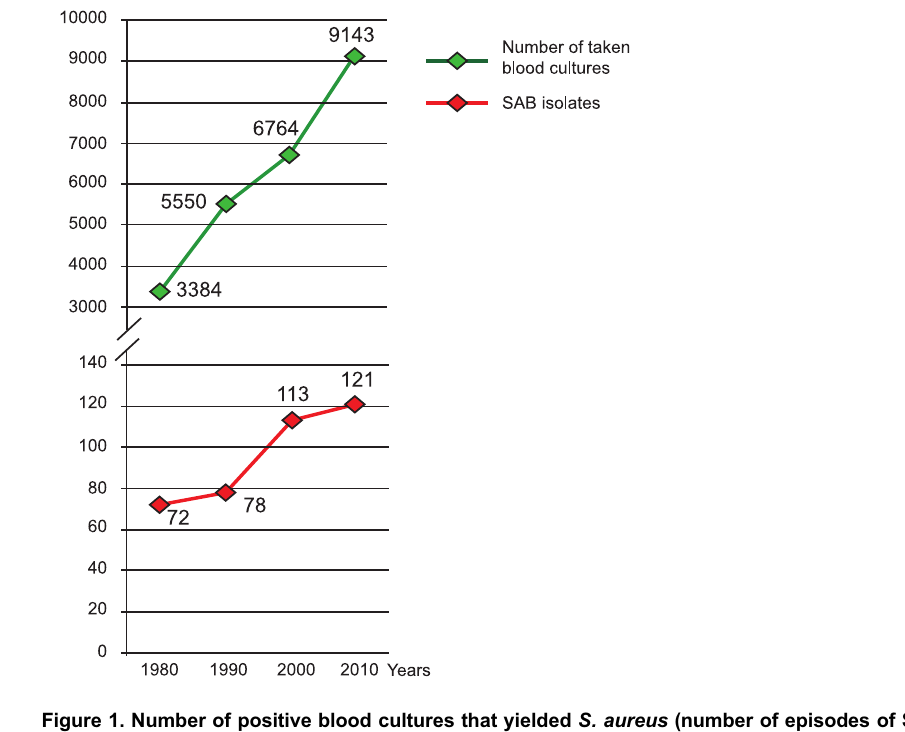
Figure 1. Number of positive blood cultures that yielded S. aureus (number of episodes of SAB) in O¨ rebro County, relative to the total blood-culturing rate in concurrent years.